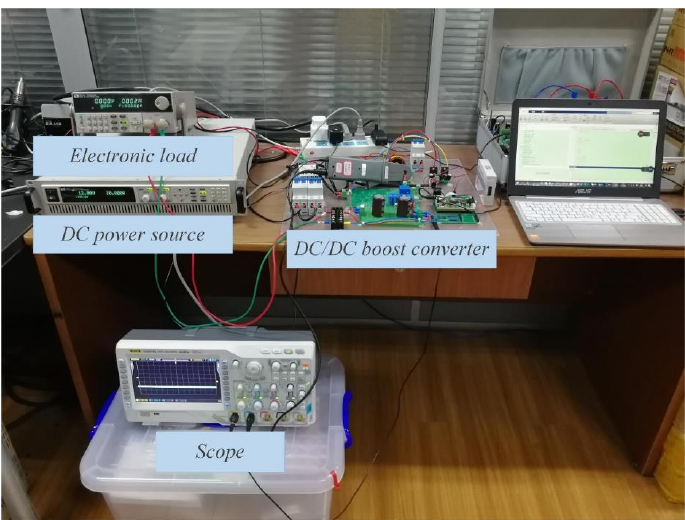
Figure 14. DC/DC boost converter experimental platform. Figure 14. DC / DC boost converter experimental